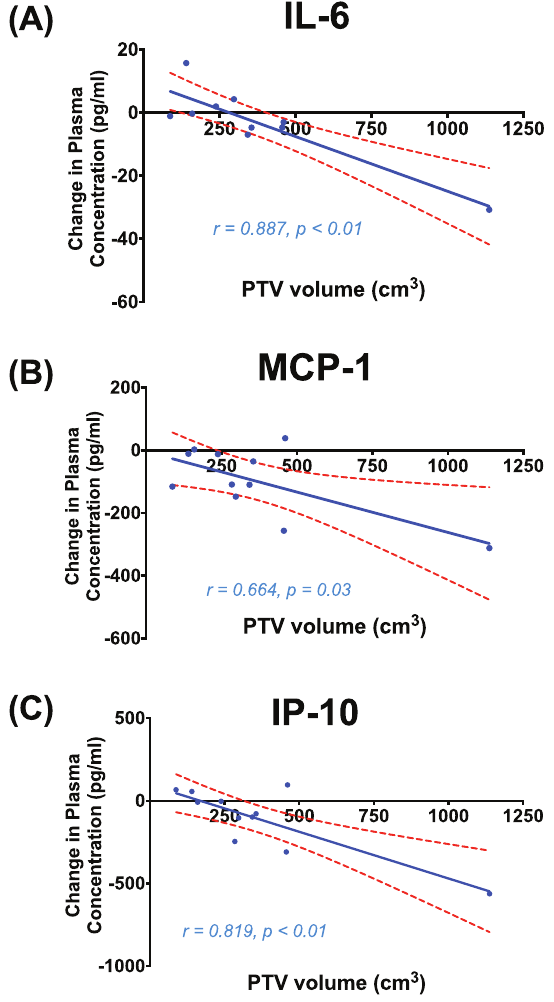
Figure 3. Correlation between irradiated PTV volume and the change in plasma cytokine concentration from baseline to 1- hour post irradiation for IL-6 (A), MCP-1 (B), and IP-10 (C). Linear-regression line (blue) is displayed with 95% confidence intervals (red broken line).